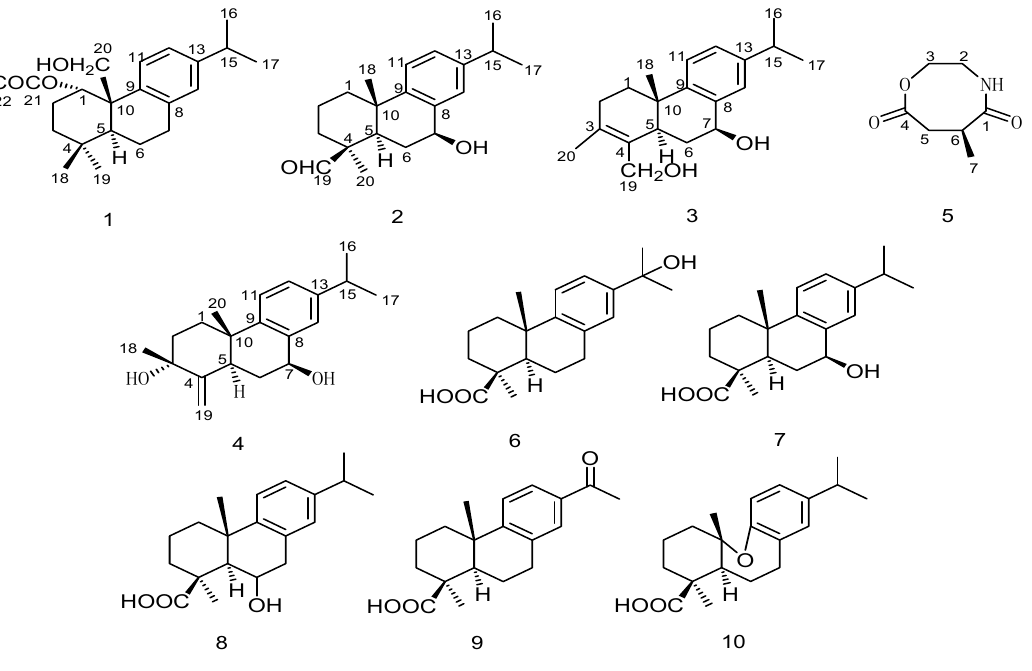
Figure 1. Structures of compounds 1 – 10 .